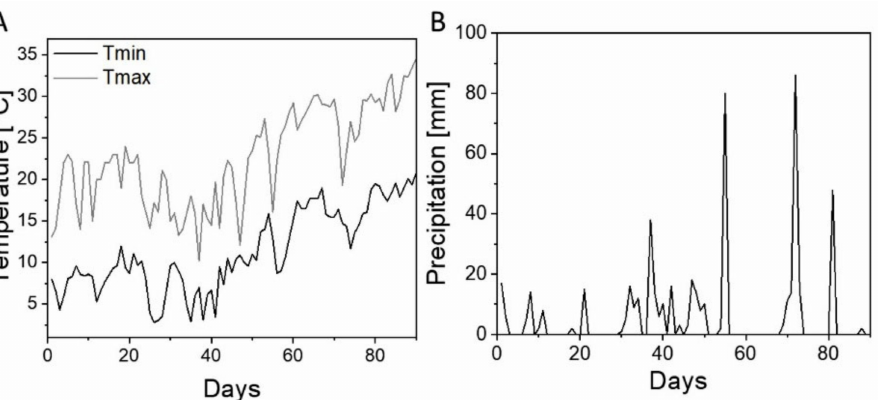
Figure 1. Ambient average temperatures and precipitation were recorded in Biella, Italy, during field trials of biocomposite biodegradation. ( A ) Indicates Tmin and Tmax temperatures in ◦ C, and ( B ) precipitation in millimeters. (Data obtained from Archivio meteo storico, Biella, Italy, 3B